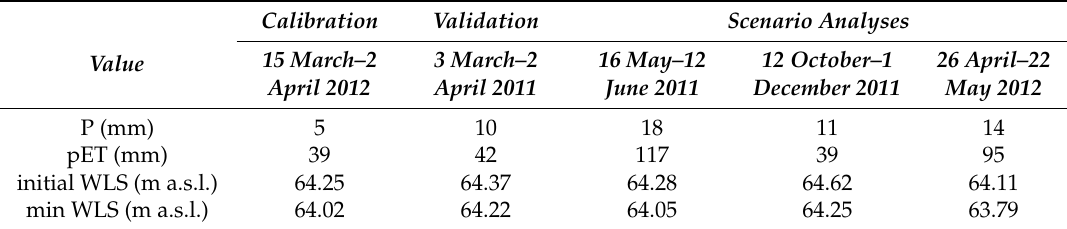
Table 3. Meteorological conditions and water levels of the Koselmühlenfließ stream (WLS) for the calibration period, validation period, and the three recession events used for scenario analyses. Calibration Value